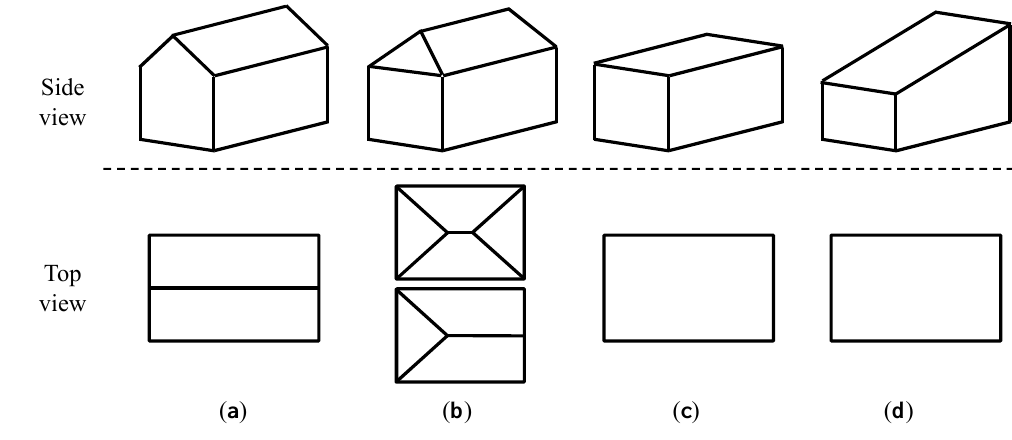
Figure 2. Building models generated by the proposed algorithm: ( a ) gable-roof,